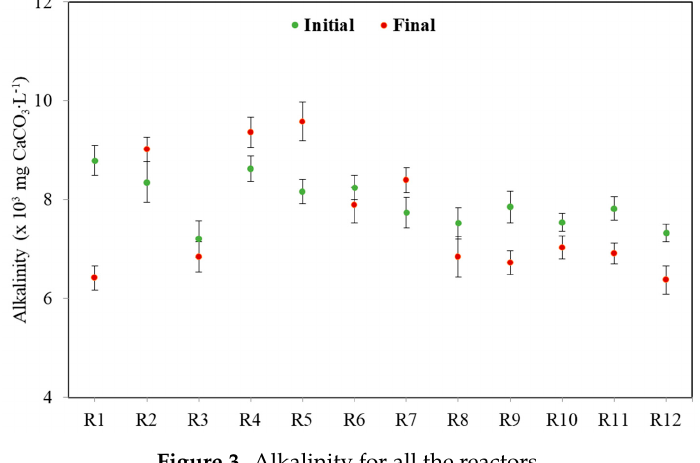
Figure 3. Alkalinity for all the reactors.